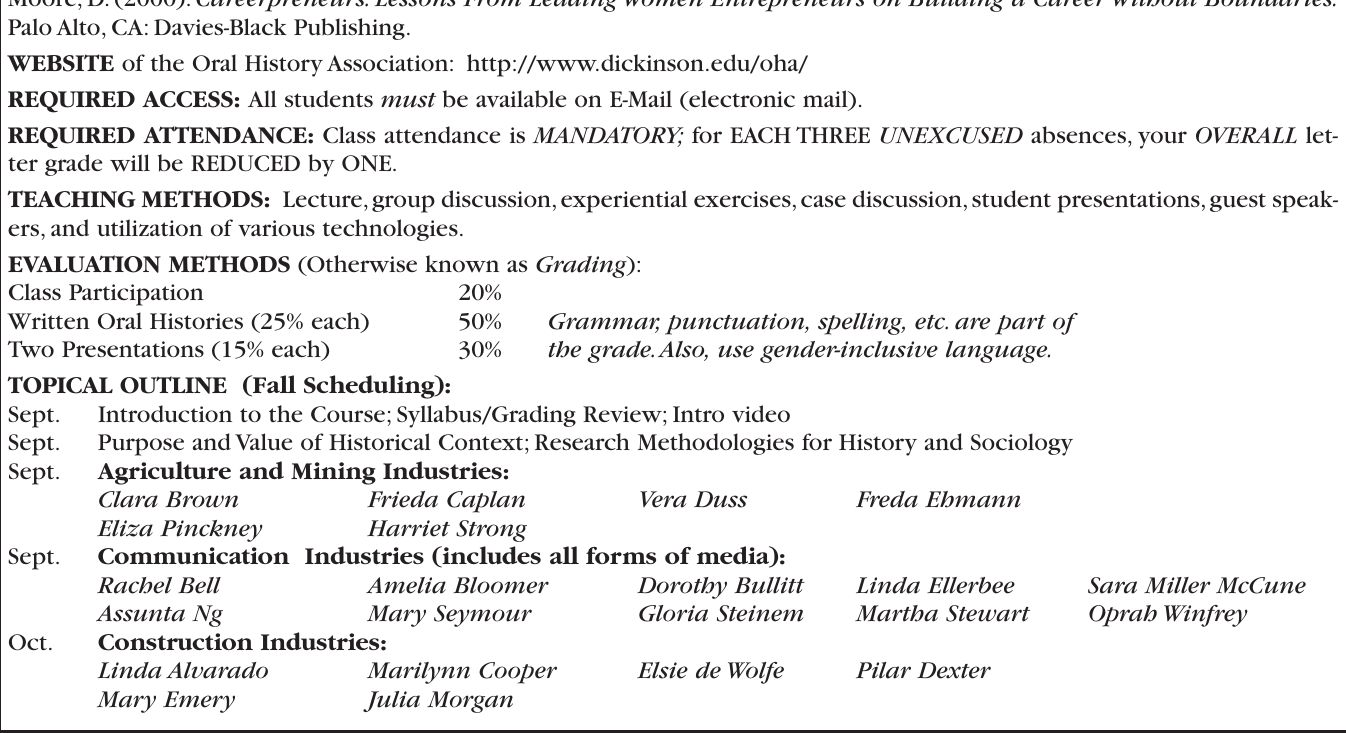
Figure 3. Sample